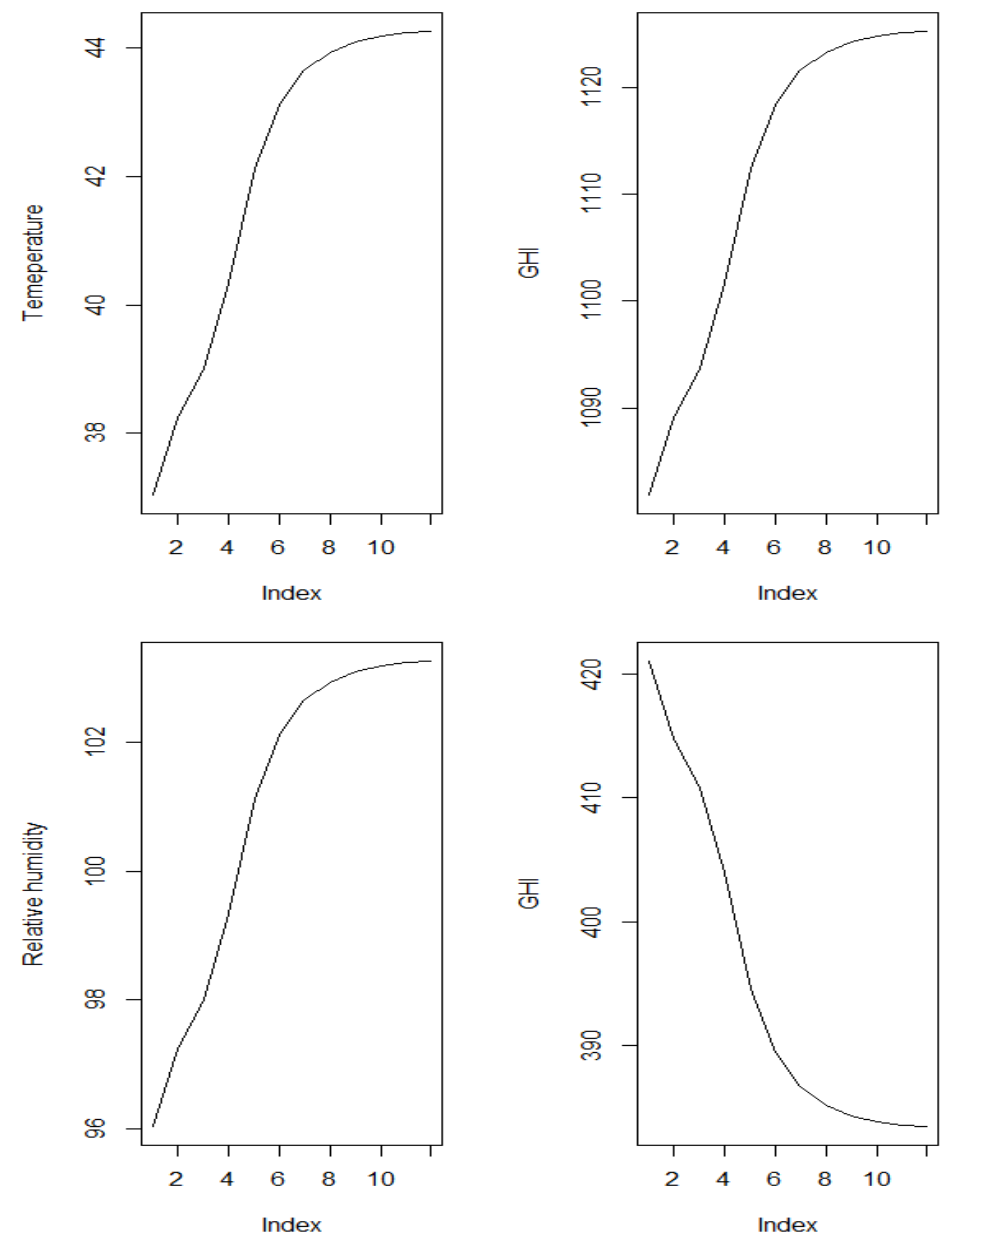
Figure 4. ( Top panel ): Plots for quantile estimation of temperature. ( Bottom panel ): Plots for quantile estimation of